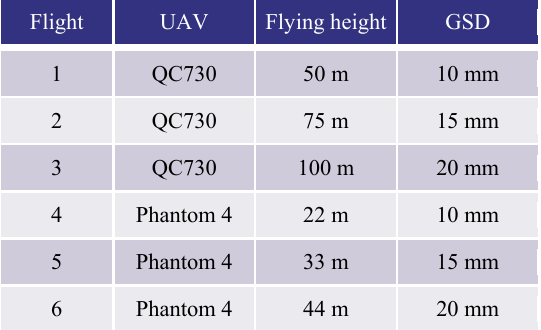
Table 2. Image acquisition plans